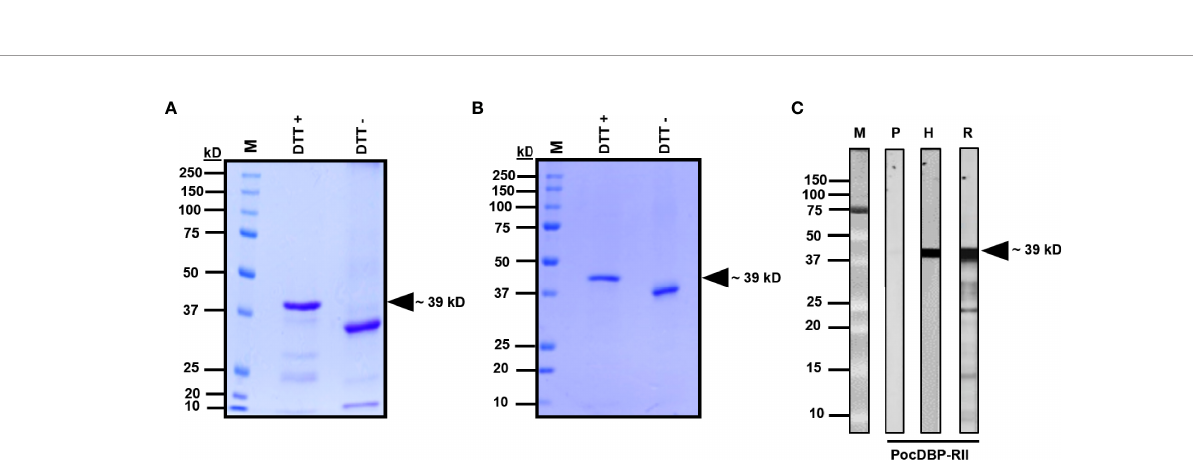
FIGURE 3 | Recombinant PvDBP-RII and PocDBP-RII protein expression and evaluation of refolding. (A, B) Coomassie blue-stained SDS-PAGE gel of recombinant PvDBP-RII and PocDBP-RII. Dithiothreitol (DTT) (-) and DTT (+) indicate the refolded protein and denatured protein, respectively, before and after treatment with 10 mM DTT. M, protein size markers. (C) Western blot analysis of the recombinant PocDBP-RII protein probed with antibodies. Black-head arrows indicate speci fi c target bands. H, anti-His antibody; R, a PocDBPRII IgG; P, preimmune rabbit